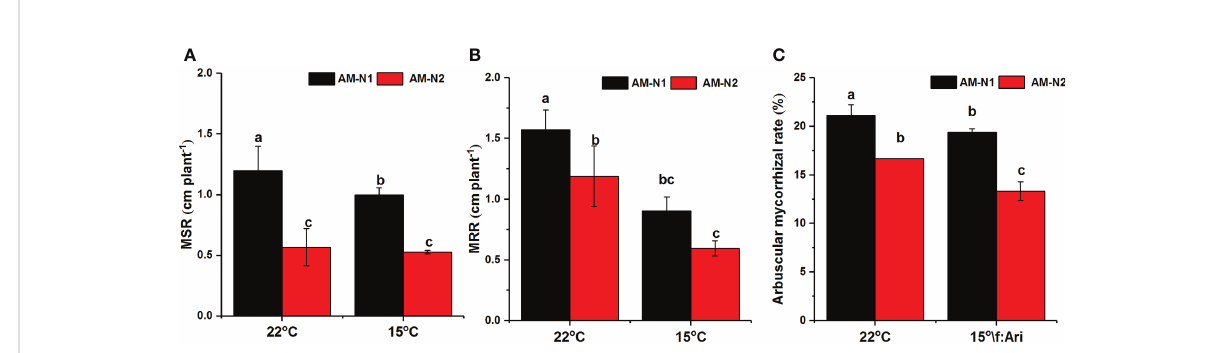
FIGURE 7 Mycorrhiza-induced increases in shoot growth (MSR) (A) , root growth (MRR) (B) and mycorrhizal colonization (C) for rice under different N and temperature conditions. Abbreviations are de fi ned in Figure 4. Values are the means ± standard errors of three biological replicates. Different letters in the column represent signi fi cant differences (P<0.05) based on Duncan ’ s